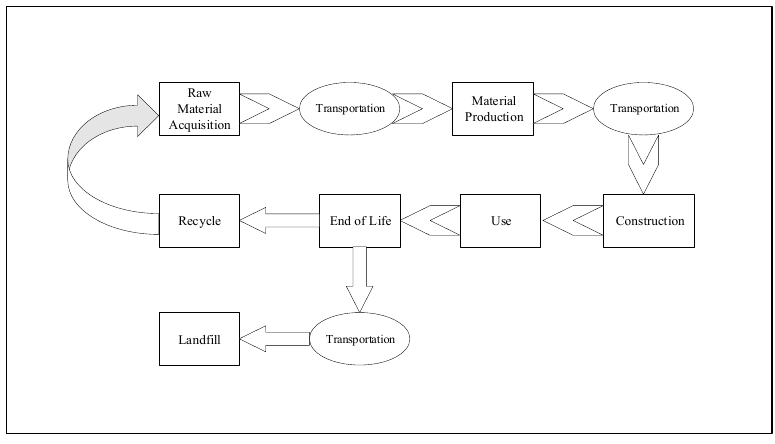
Figure 4. System boundary.